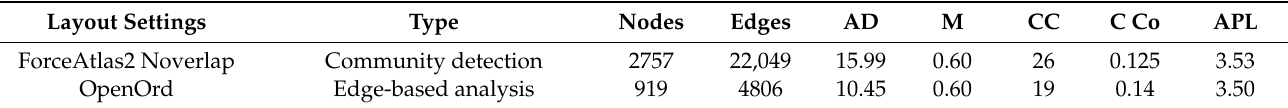
Table 3. Network-level properties of ACL ARC citations network for community detection and edges-based analysis across Average Degree (AD), modularity (M), connected component (CC), clustering coefficient (C Co), average path length (APL). Layout Settings